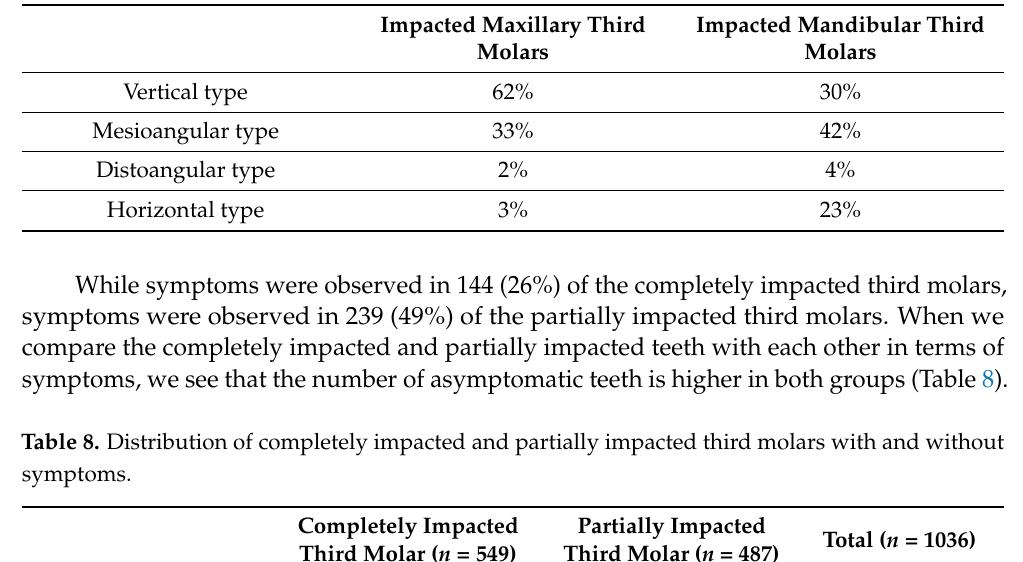
Table 7. Distribution of impacted maxillary and mandibular third molars by